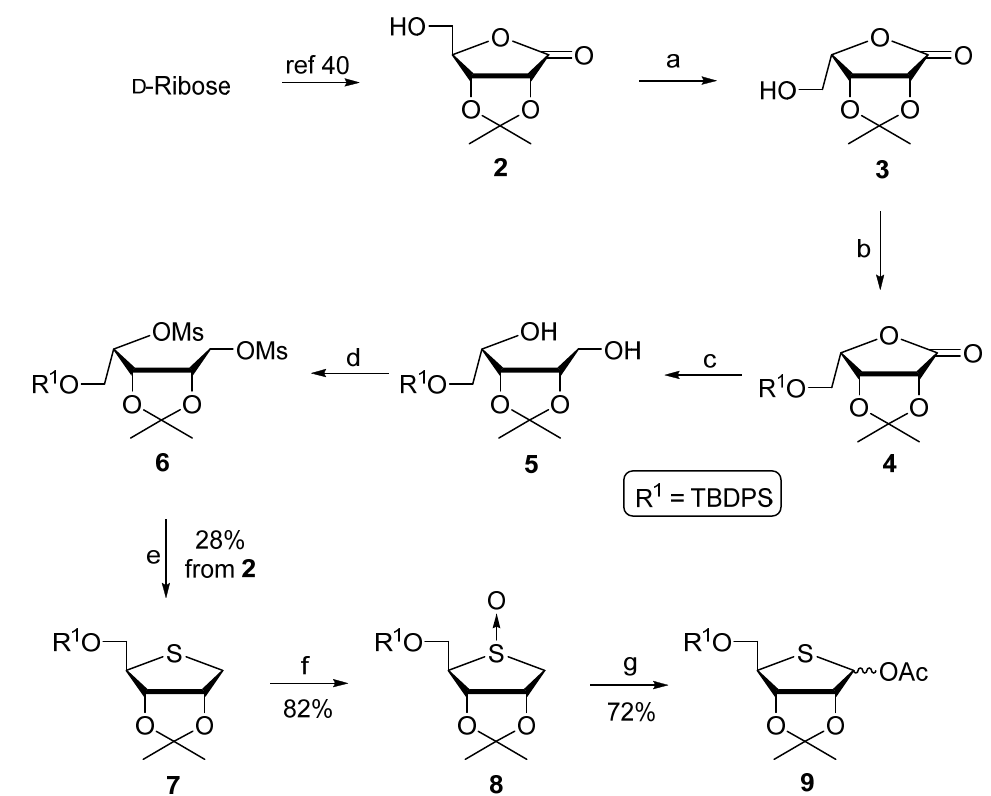
Figure 2. The structures of target nucleoside analogs were modified at the C7 position. As shown in Scheme 1, to synthesize the final nucleoside 1 , we first synthesized the glycosyl donor 9 from commercially available D